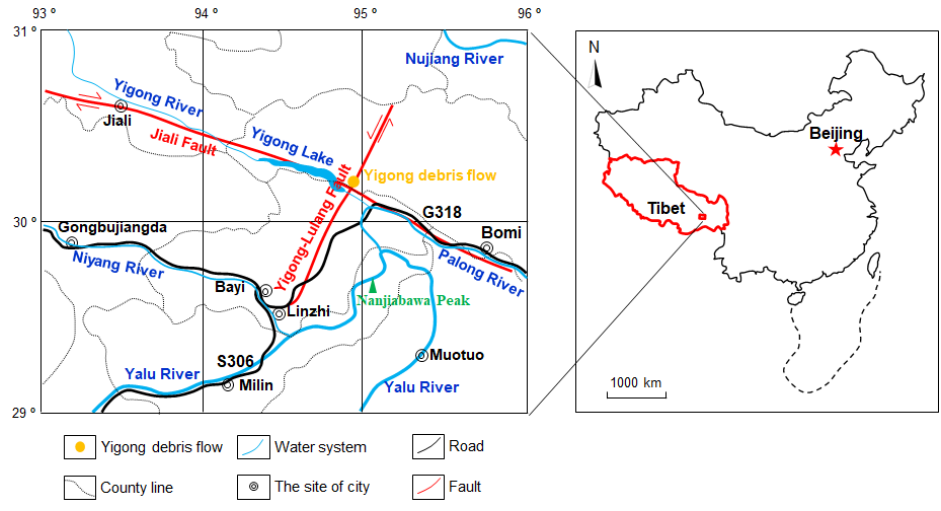
Figure 1. Location of the Yigong debris flow. The study area belongs to the temperate subhumid plateau monsoon climate area. Influenced by the warm–wet air currents from the Indian Ocean, the weather is humid, with clear four seasons and abundant in rainfall and sunshine. According to the local meteorological station, the annual rainfall averages 876.9 mm, and the cumulative sunshine hours is 1544 h. It was reported that the antecedent precipitation from 1 to 9 April 2000 was 42.9 mm, which was a main trigger of the debris flow. According to the three weather stations around Yigong area, the mean ground surface temperature in this area gradually increased before the occurrence of the Yigong debris flow [40]. It might result in the glacier melting in the source area and, thus, may have increased the pore water pressure in the geomaterials and decreased the shear